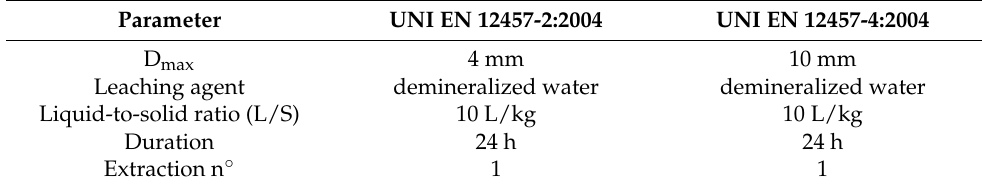
Table 2. Comparison between the applied test methods (UNI EN 12457-2 and UNI EN 12457-4). Parameter UNI EN 12457-2:2004 UNI EN 12457-4:2004 D max 4 mm 10 mm Leaching agent demineralized water demineralized water Liquid-to-solid ratio (L/S) 10 L/kg 10 L/kg Duration 24 h 24 h Extraction n ◦ 1 1